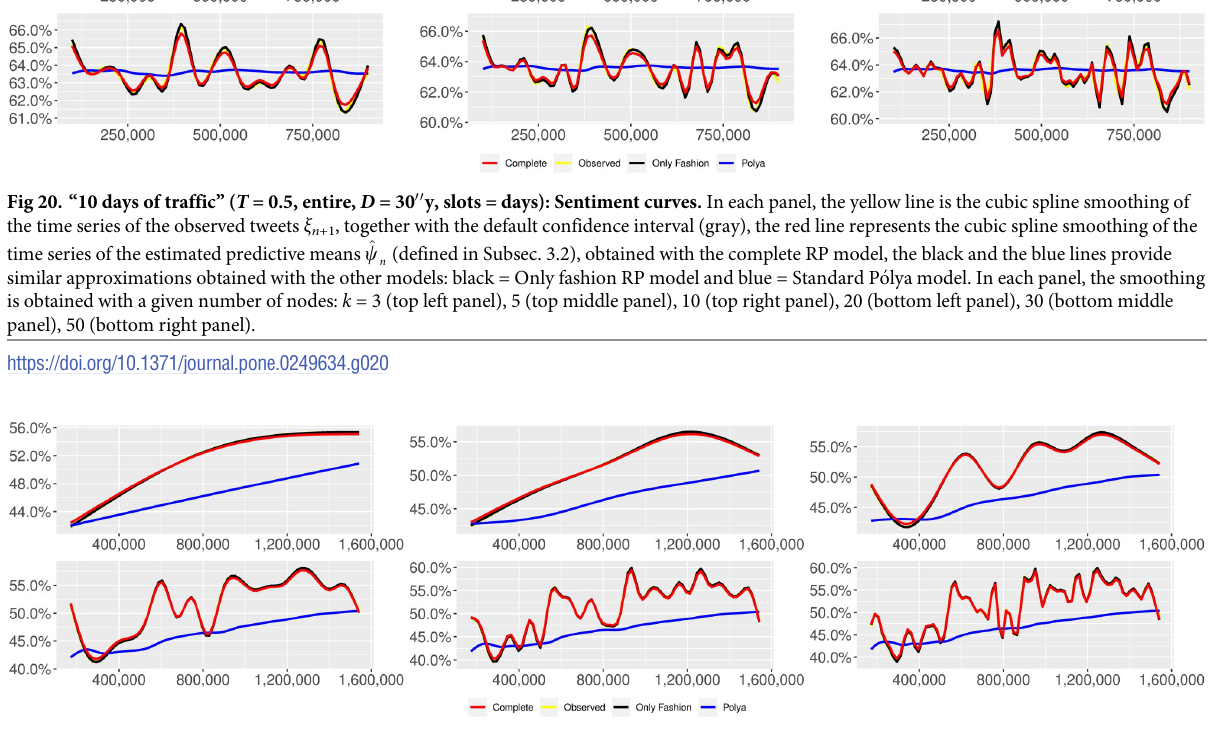
Fig 21. “Covid” ( T = 0.5, entire, � D = 3 0 , S = 100 slots of equal size): Sentiment curves. In each panel, the yellow line is the cubic spline smoothing of the time series of the observed tweets ξ , together with the default confidence interval (gray), the red line represents the cubic spline smoothing of the n +1 time series of the estimated predictive means ^ c (defined in Subsec. 3.2), obtained with the complete RP model, the black and the blue lines provide n similar approximations obtained with the other models: black = Only fashion RP model and blue = Standard Po´lya model. In each panel, the smoothing is obtained with a given number of nodes: k = 3 (top left panel), 5 (top middle panel), 10 (top right panel), 20 (bottom left panel), 30 (bottom middle panel), 50 (bottom right panel).